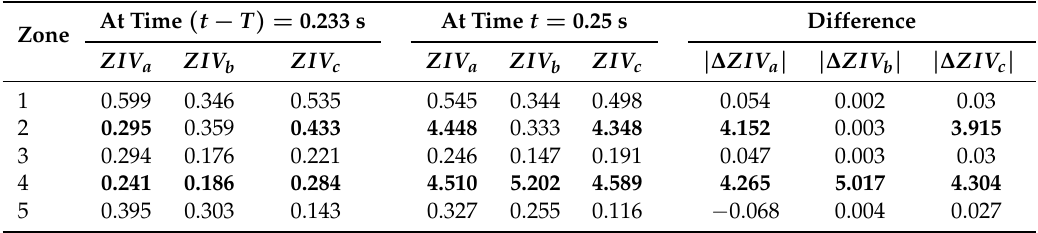
Table 2. | ∆ ZIV | vectors for phase a,b,c for test case 2 for fault detection at t = 0.25 s. (The value shown in bold indicate fault on respective phases. All the values shown are calculated in